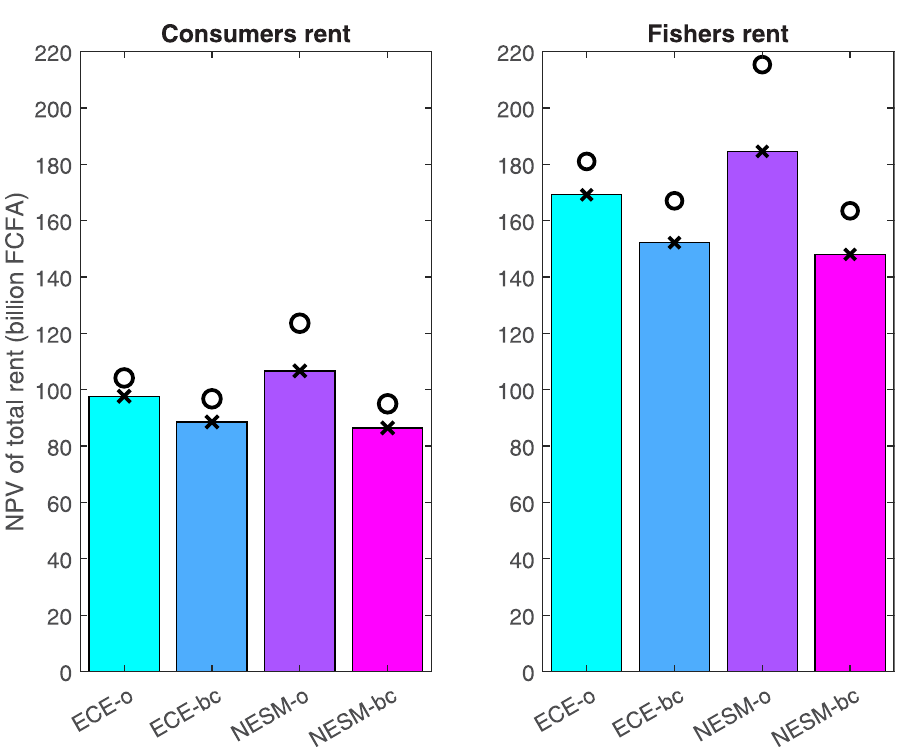
Fig 8. NPV of total rents per model (Bars represent rents under BAU. Shapes represent fuel subsidy scenarios (crosses: BAU, circles: melt-down).